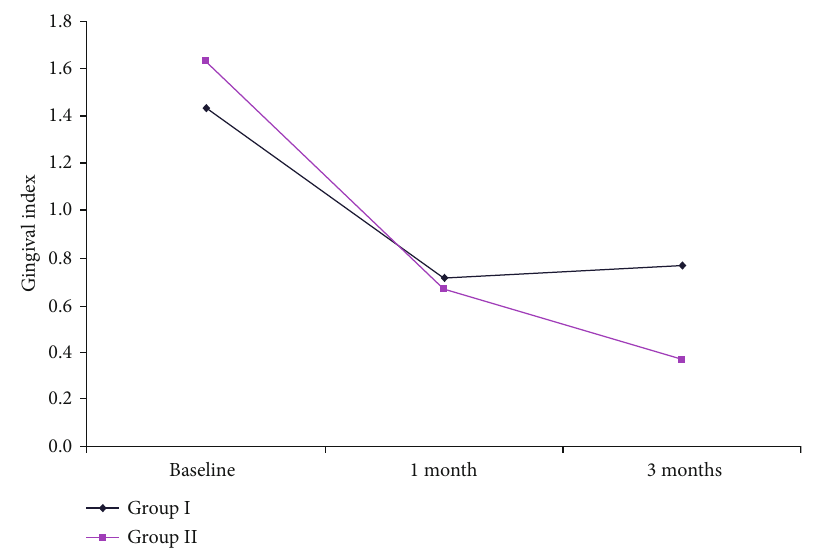
Figure 1: The mean GI reduction in Group I and Group